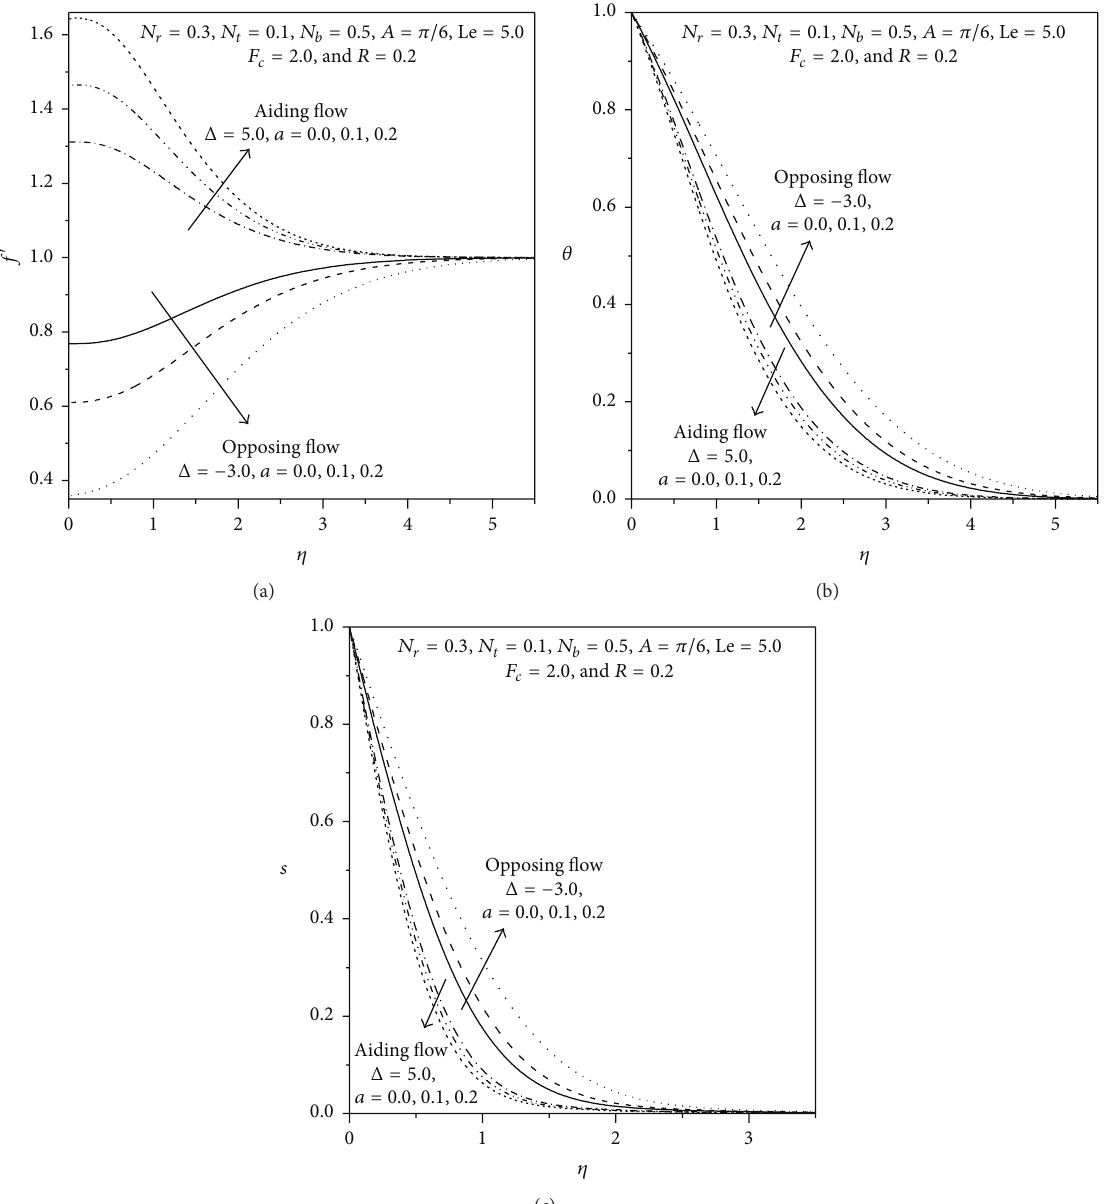
Figure 2: Variation of (a) velocity, (b) temperature, and (c) nanoparticle volume fraction profiles with the wave amplitude ( 𝑎 ).